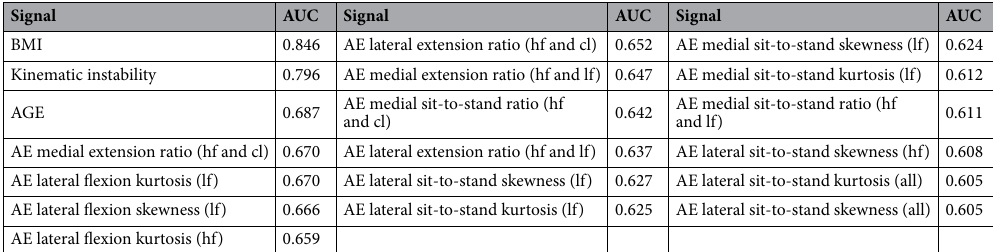
Table 1. AUC values of the best test result variables in females. AE acoustic emission, BMI body mass index, hf high frequency, lf low frequency, cl clicks, all high and low frequency.